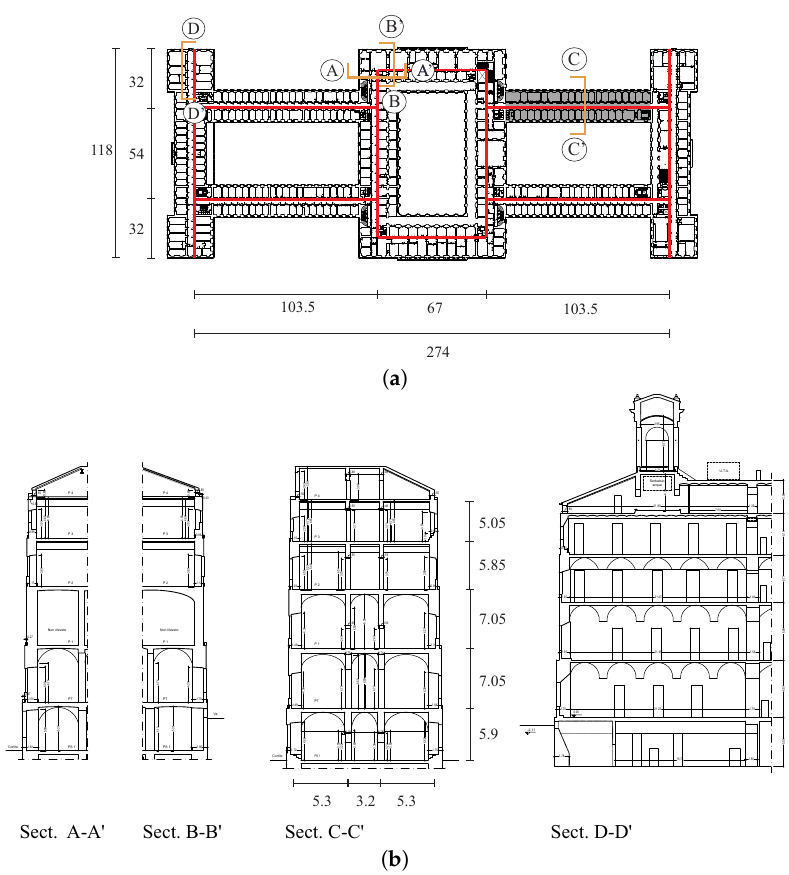
Figure 1. ( a ) plan of the first level: (red) middle line and highlighted (gray filled area) longitudinal arm; ( b ) sections. All the units are in